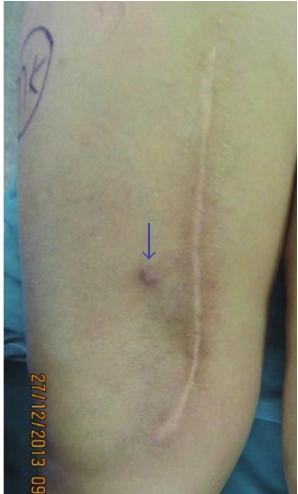
Figure 1: Clinical photograph shows cutaneous relapse.